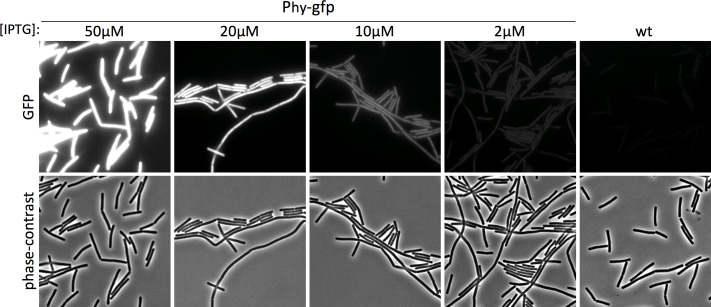
Expression from the IPTG-regulated promoter (Phyperspank) is homogenous across all cells in the population.Representative images of cells expressing cytoplasmic GFP from the Phyperspank (Phy) promoter. Cells were grown in LB medium and induced with the indicated concentrations of IPTG and imaged 60 min later. Wild-type cells (wt) that lack the GFP were used as a negative control.